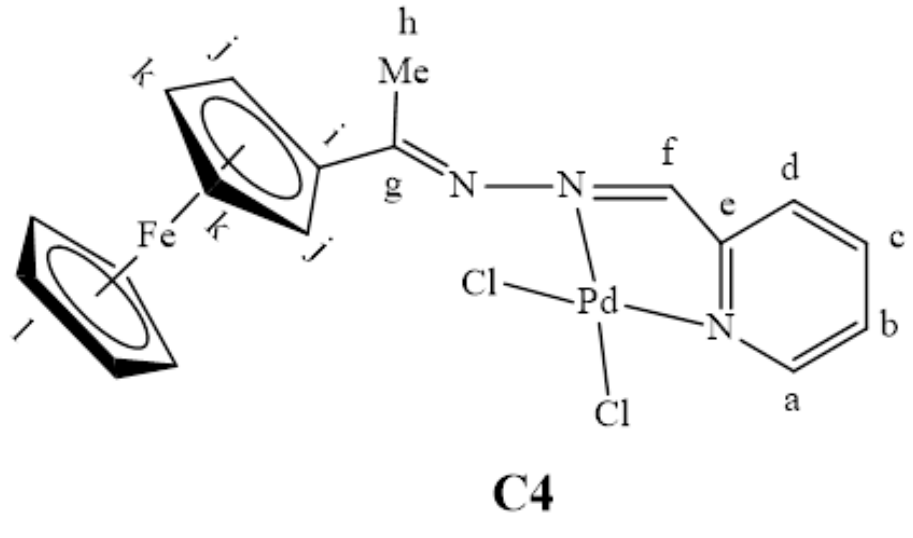
Figure 30. The chemical structure of C4 .